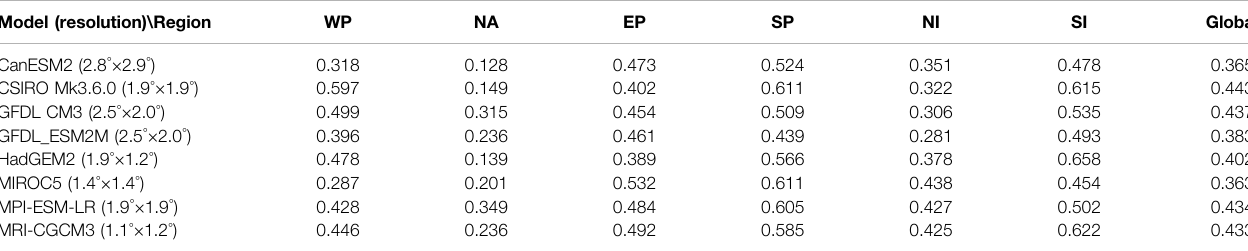
TABLE 4 | Comprehensive evaluation index (CEI) for the eight CMIP5 models in different areas and globe. Model (resolution)\Region WP NA